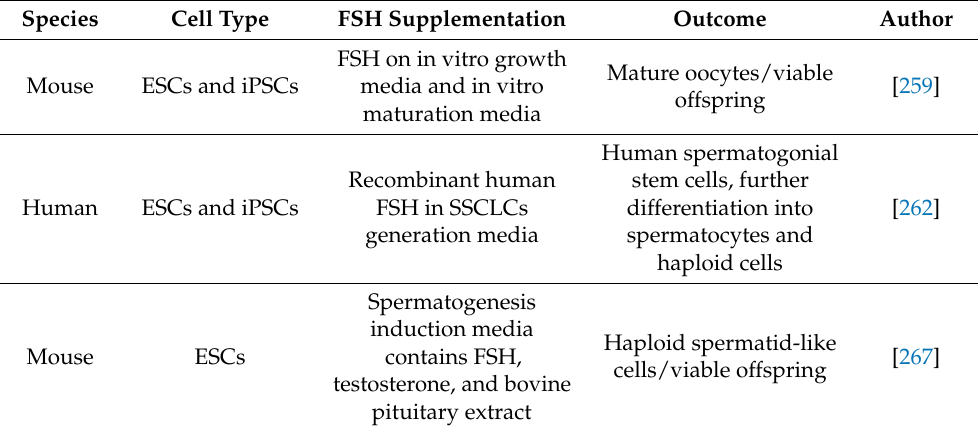
Table 1. The use of FSH in vitro to SSCLCs generation and oocyte maturation from ESCs or iP- SCs